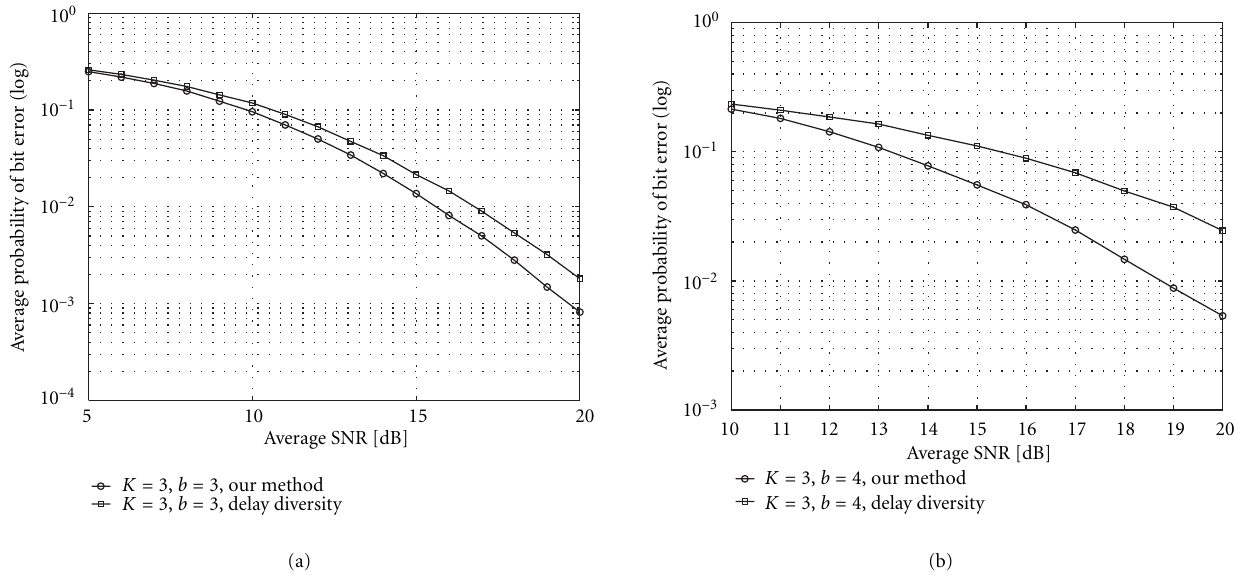
Figure 6: Simulation results II. (a) Three transmit antennas with 8PSK, (b) three transmit antennas with